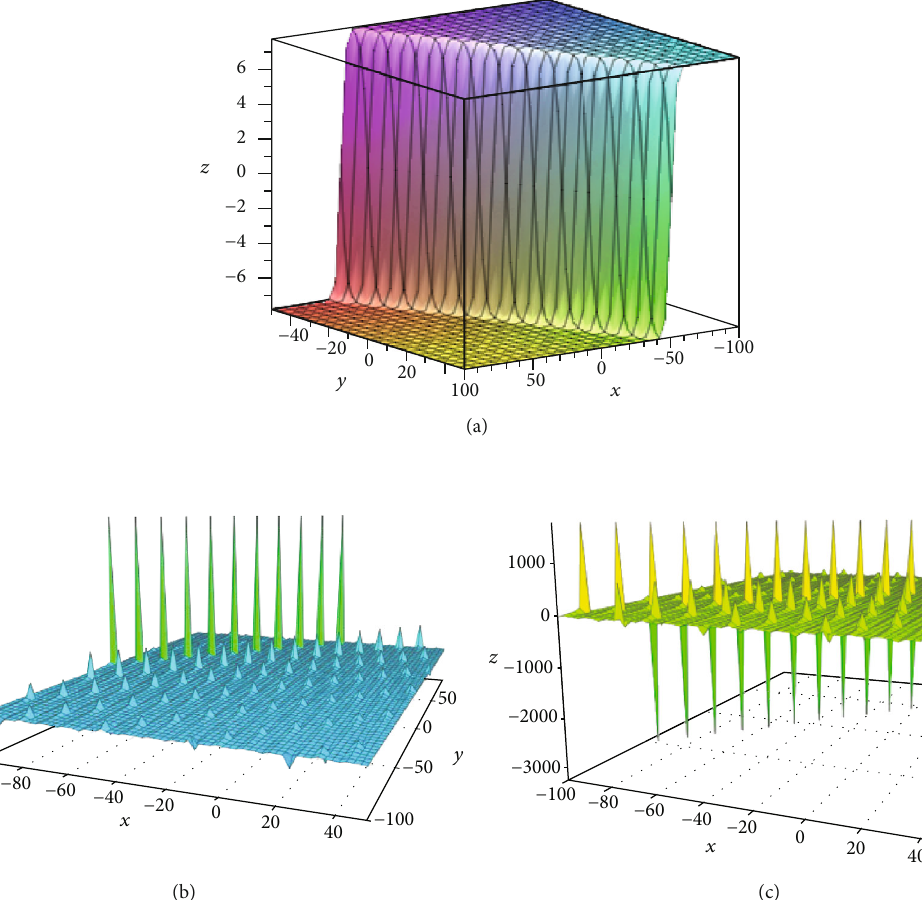
Figure 1: (a – c) Illustrations of the solitary wave solutions in di ff erent dimensions; in the physical description, we give more complete illustrations of (55), (66), and (70a) by using maple plots for the solitary wave solutions u equation (36), with N = 1, 2 , and 3 , respectively, when e = 0 : 5 , r = 0 : 5 , s = − 2 , C